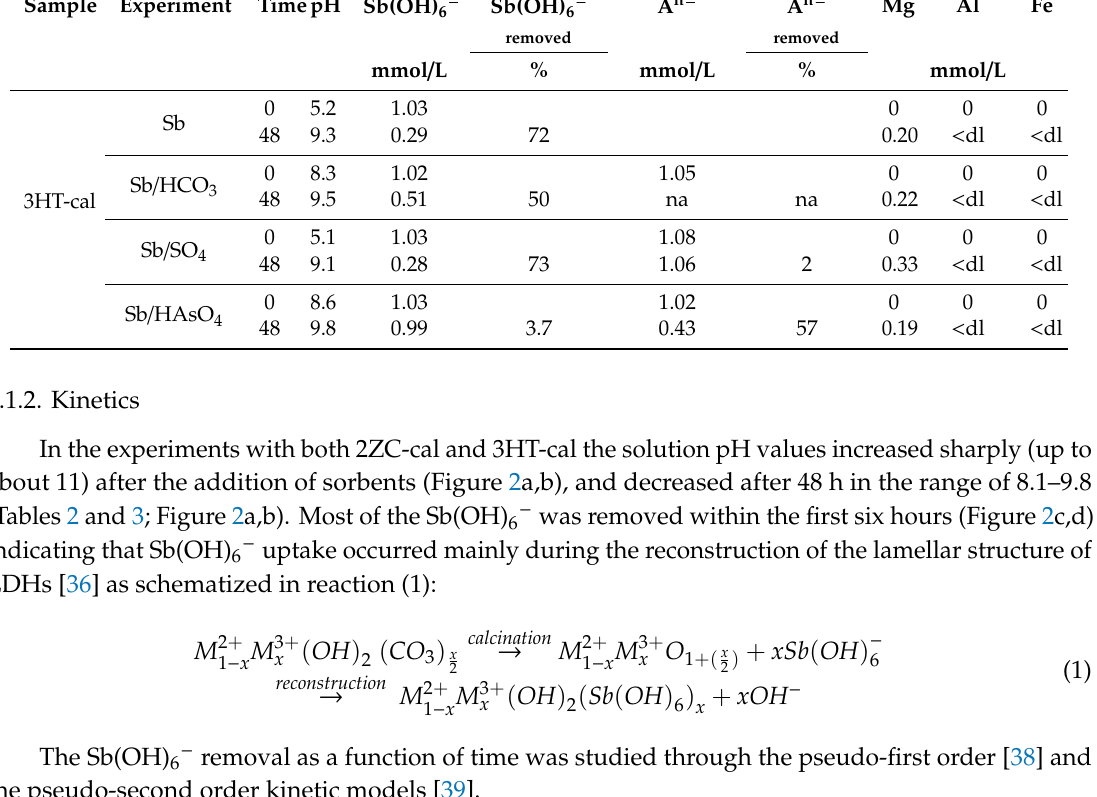
Table 3. Solution pH values and dissolved ions determined before and at the end of the sorption experiments performed with 3HT-cal without competitors (Sb), and with coexistent HCO 3 − (Sb / HCO 3 ), SO 42 − (Sb / SO 4 ) or HAsO 42 − (Sb / HAsO 4 ). (A n − = HCO 3 − , SO 42 − or HAsO 42 − ; na = not analyzed; dl = detection limit; dl Al = 7 µ mol / L; dl Fe = 1 µ mol / L). Sample Experiment TimepH Sb(OH) 6